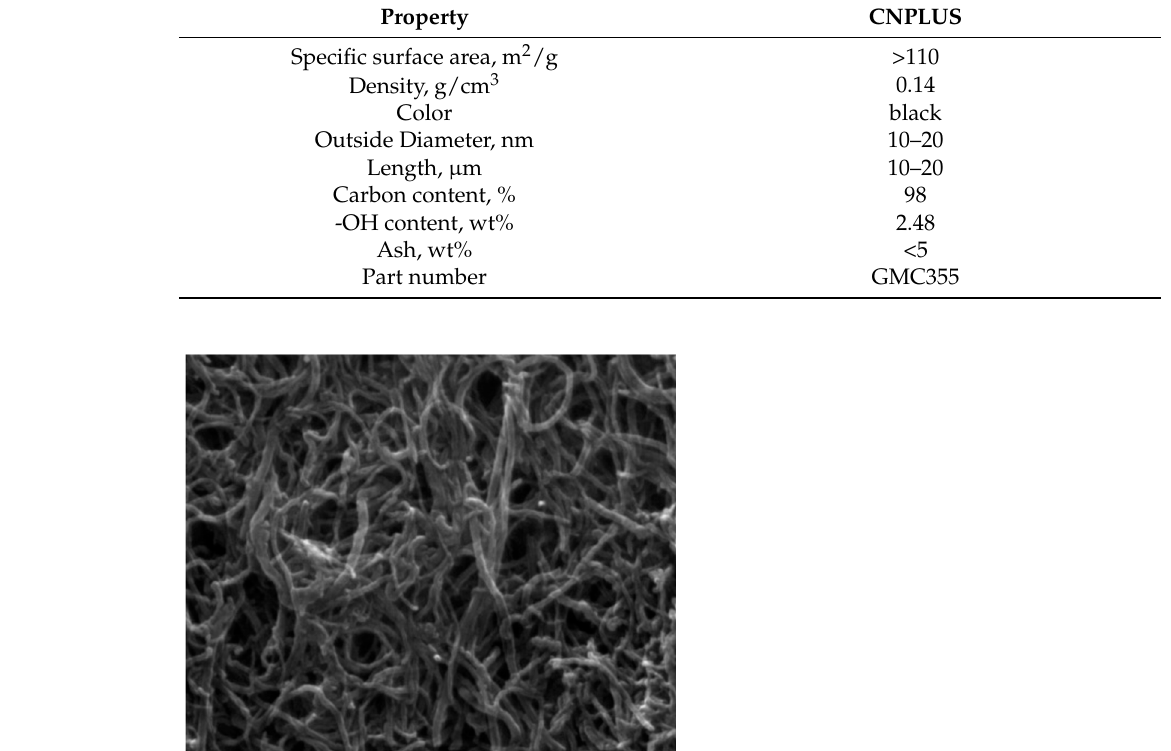
Table 2. CNPLUS characteristics.